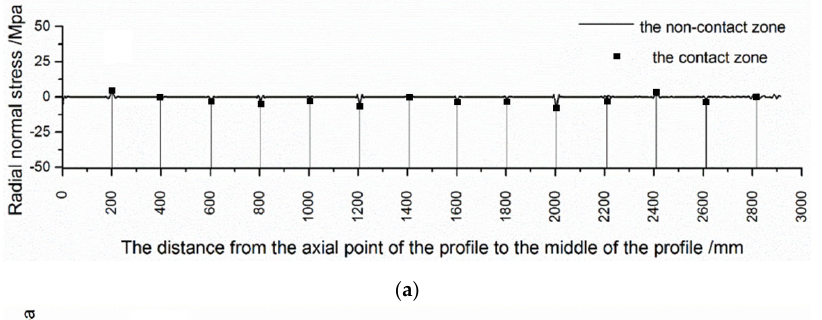
Figure 8. The axial normal stress along path a.